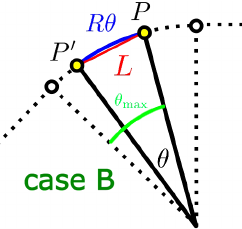
FIG. 6. Geometry for case B. Note that the θ here is not the same as the θ defined in case A. The θ θ in case